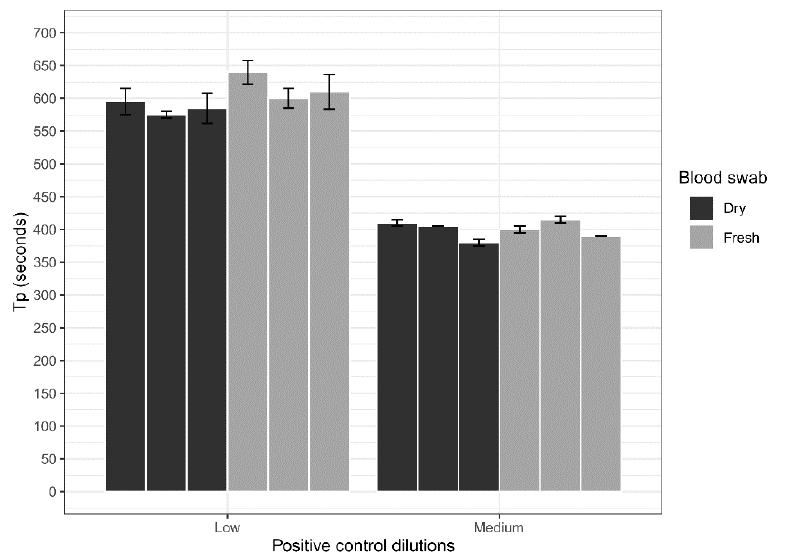
Figure 4. Comparison of dry and fresh blood swabs on the detection sensitivity of the ASFV LAMP assay, using porcine blood spiked with a low concentration (200 copies / µ L) and medium concentration (20,000 copies / µ L) of the ASFV gBlock.